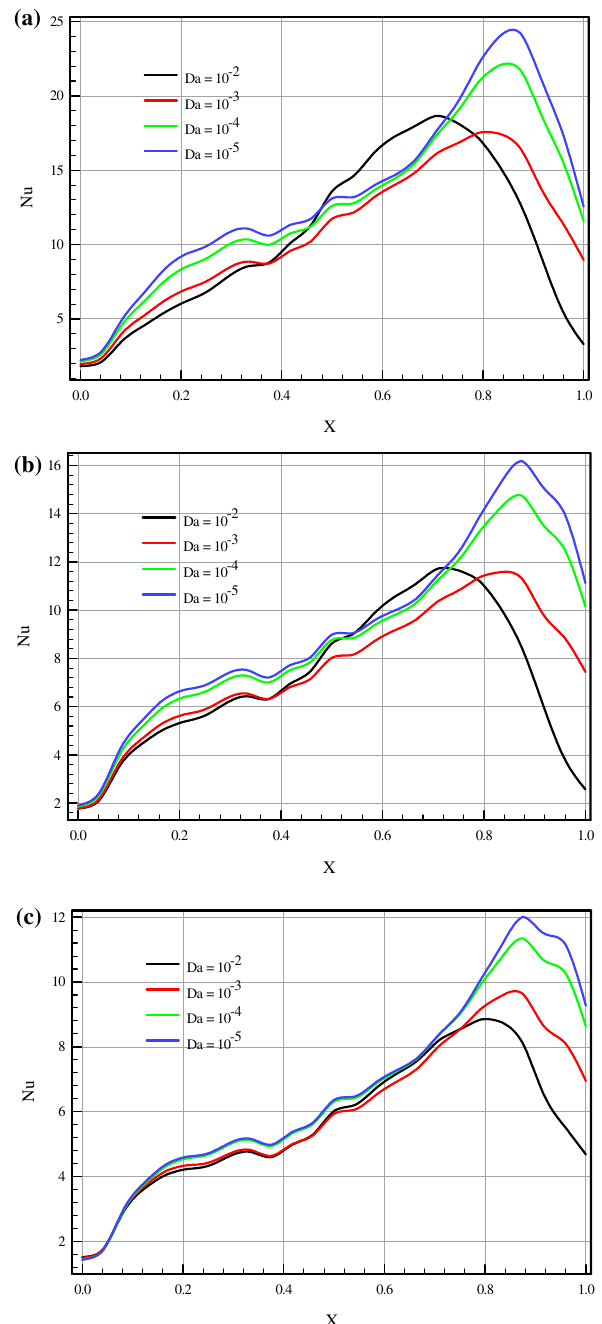
Figure 4. ( a ) Nusselt number along lower wall for Ri = 0.1, ɛ = 0.5, τ = 0.1. ( b ) Nusselt number along lower wall for Ri = 1, ɛ = 0.5, τ = 0.1. ( c ) Nusselt number along lower wall for Ri = 10, ɛ = 0.5, τ =